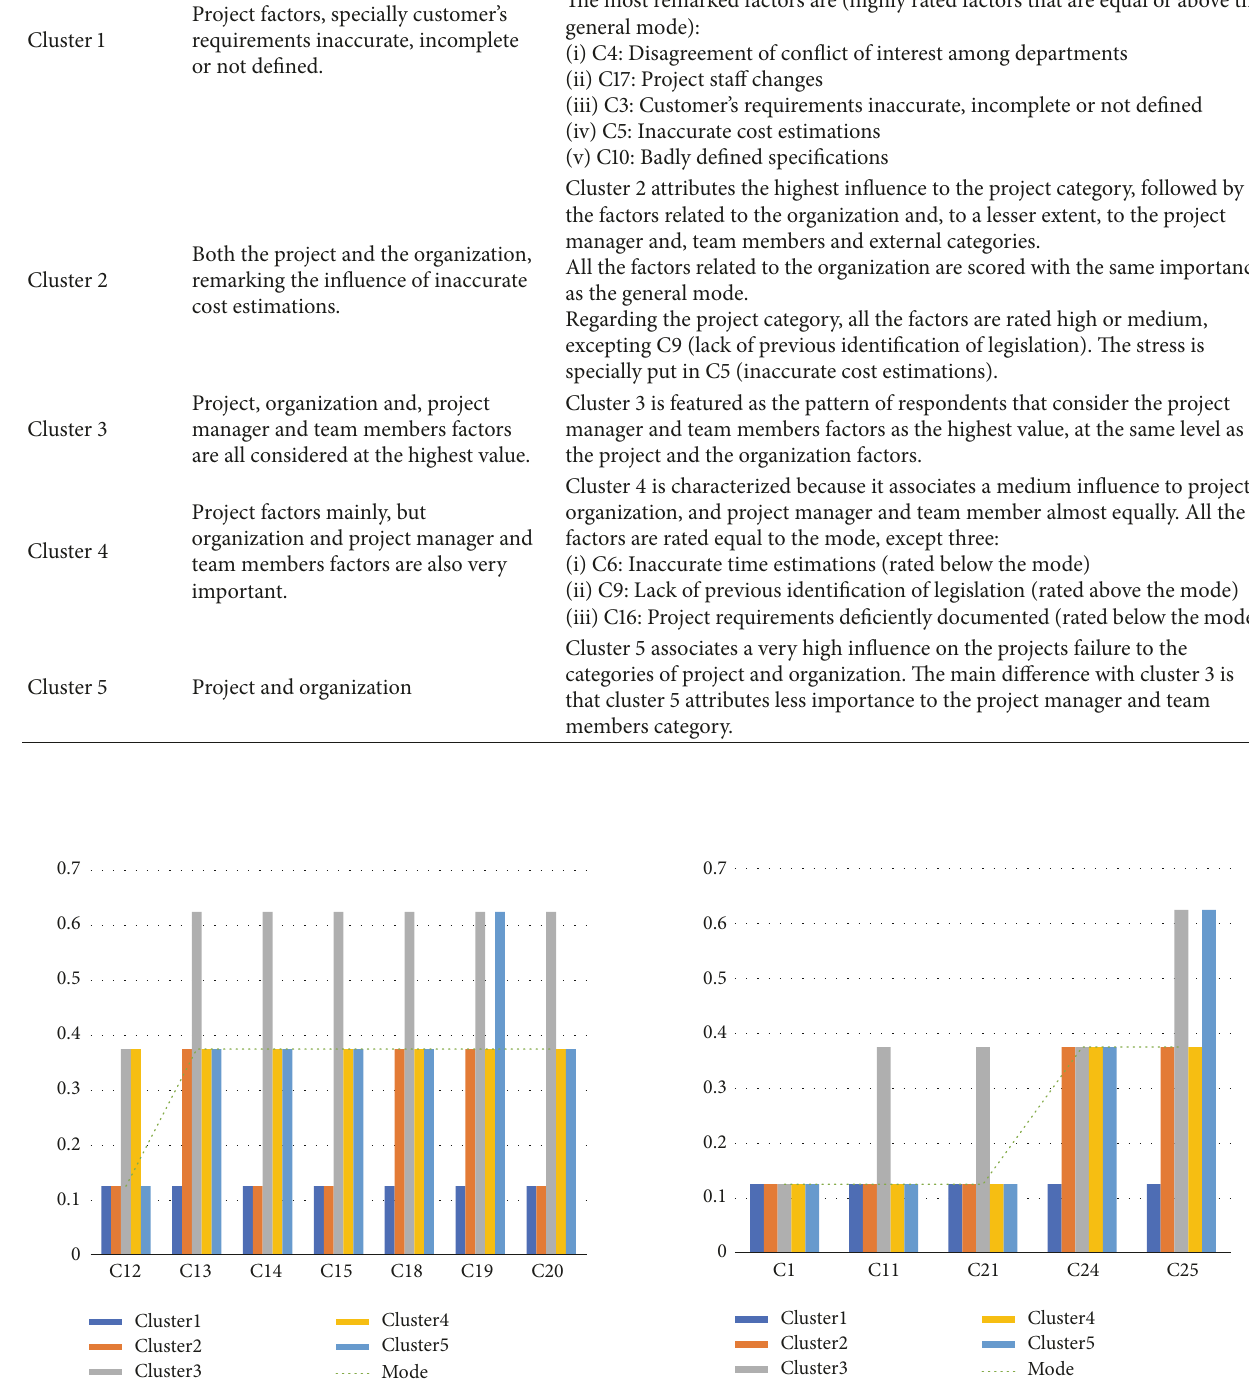
Figure 11: External factors and clusters bar chart. Factor importance average score of each cluster plotted against the mode of the global